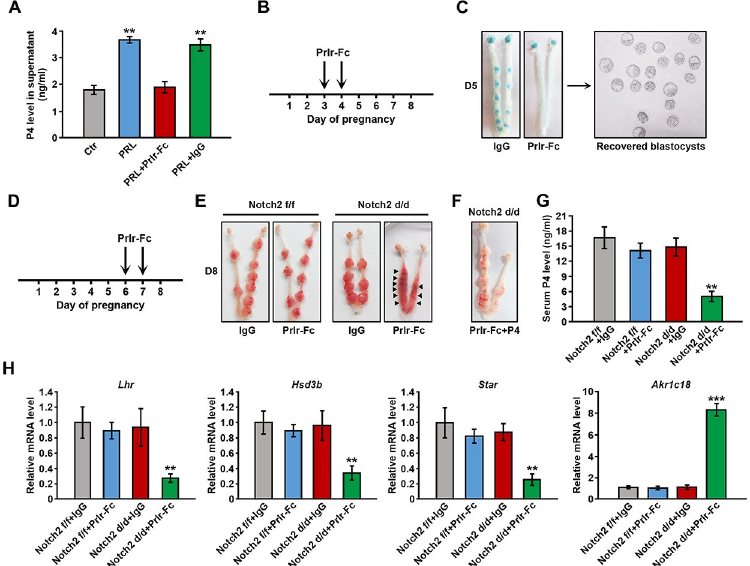
Fig 4. Notch2 d/d females ended up in abortion when Prl signaling was blocked. (A) P4 level in the supernatant of cultured CL cells was measured upon PRL, PRL+Prlr-Fc or PRL+IgG treatment. (B) The scheme shows the schedule of Prlr-Fc treatment. (C) Females treated with Prlr-Fc failed in implantation on day 5 despite the presence of morphologically normal blastocysts. (D) The schedule of Prlr-Fc treatment is shown. (E) Notch2 d/d females with Prlr- Fc administration suffered from pregnancy loss. Arrowheads indicate absorbed implantation sites. (F) Exogenous P4 supplementation alleviated abortion in Notch2 d/d females with Prlr-Fc administration. (G) The serum P4 level was measured in Notch2 f/f and Notch2 d/d females after Prlr-Fc treatment. (H) The relative mRNA level of genes related to P4 synthesis or degradation was examined by QRT-PCR analysis in ovaries of Notch2 f/f and Notch2 d/d females with Prlr-Fc administration. Mice with IgG administration were used as control. Data in (A), (G) and (H) represents mean ± SEM. �� p < 0.01, ��� p <